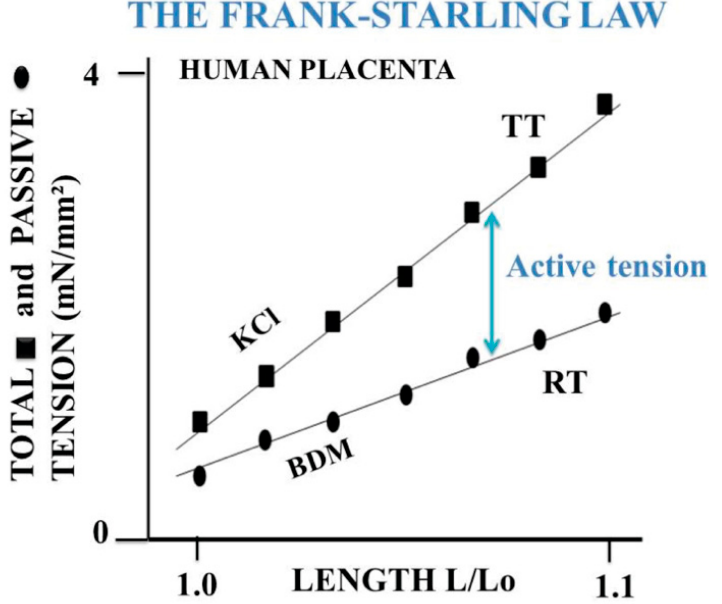
Figure 5. Frank-Starling mechanism. The Frank-Starling law indicates that when the initial length at rest (Lo) of the contractile sample increases, the active isometric tension also increases. The passive resting tension is measured in the presence of BDM, which inhibits the CB molecular motor interactions. Total isometric tension (TT in mN) is measured as a function of increasing initial length (Lo) of placental stem villi. Active isometric tension is the difference between total isometric tension and passive resting tension (RT) and increases when Lo increases. This cardinal mechanical property is shared by both contractile muscles and non-muscle contractile tissues.